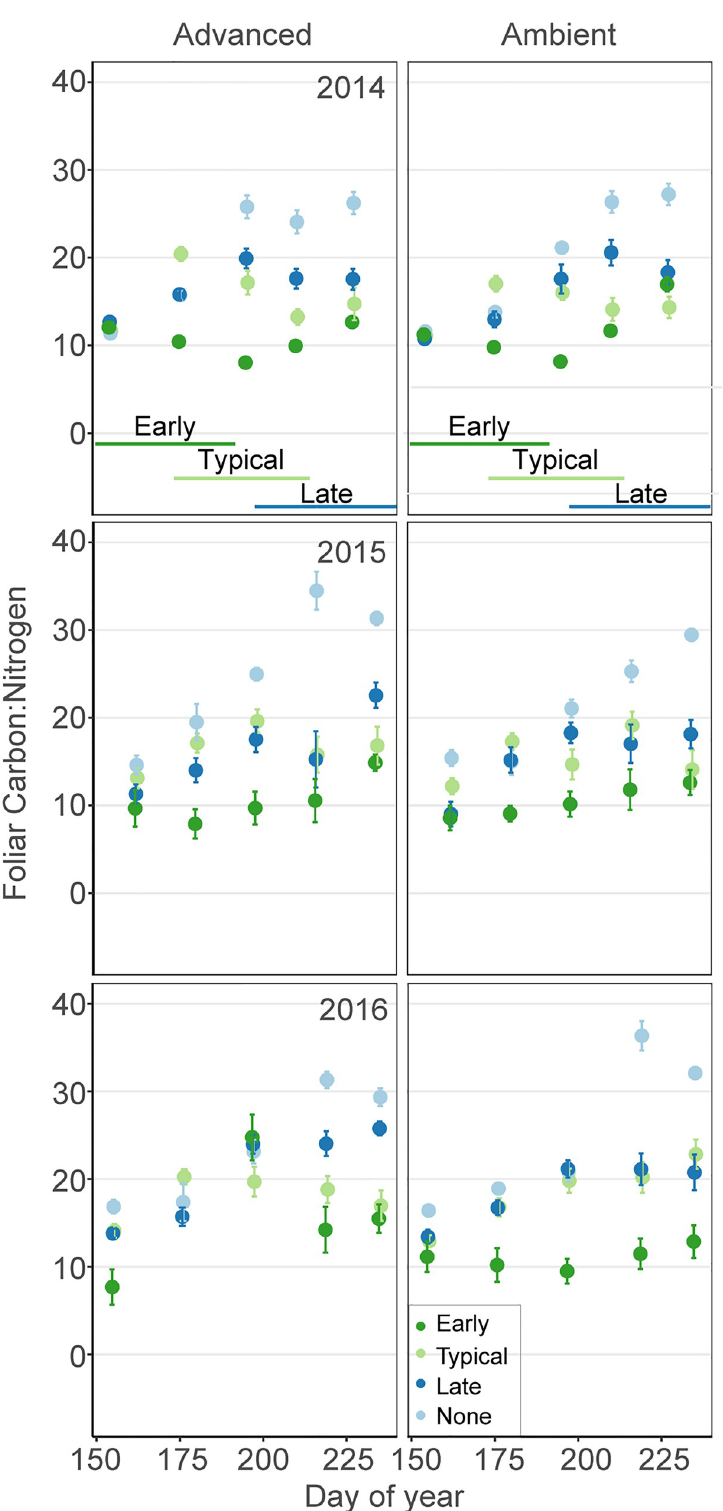
Fig 5. Foliar C:N ratios. Mean C:N ratios ( ± 1 SE) for treatment plots across the growing season from 2014–2016 (n = 6 replicates/treatment). Treatments included advanced and ambient growing seasons, and early, typical, late and no grazing. Lines on the bottom show the timing of the early, typical and late grazing treatments.